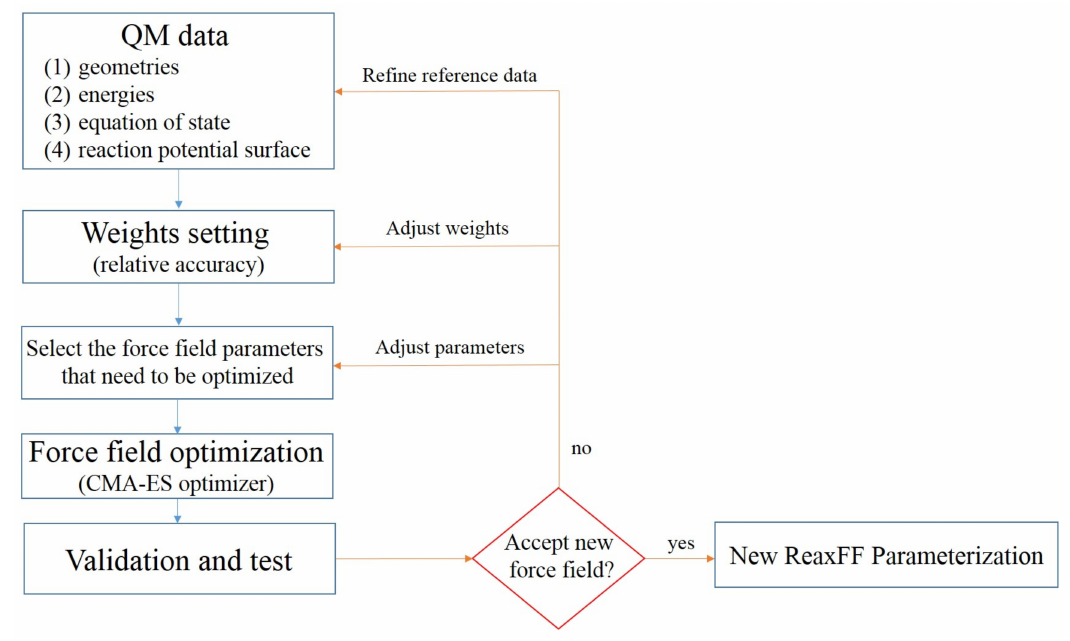
Figure 1. Workflow of the ReaxFF